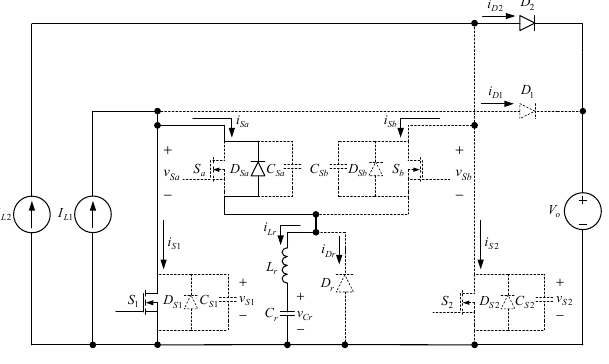
Figure 8. Current path in mode 5.